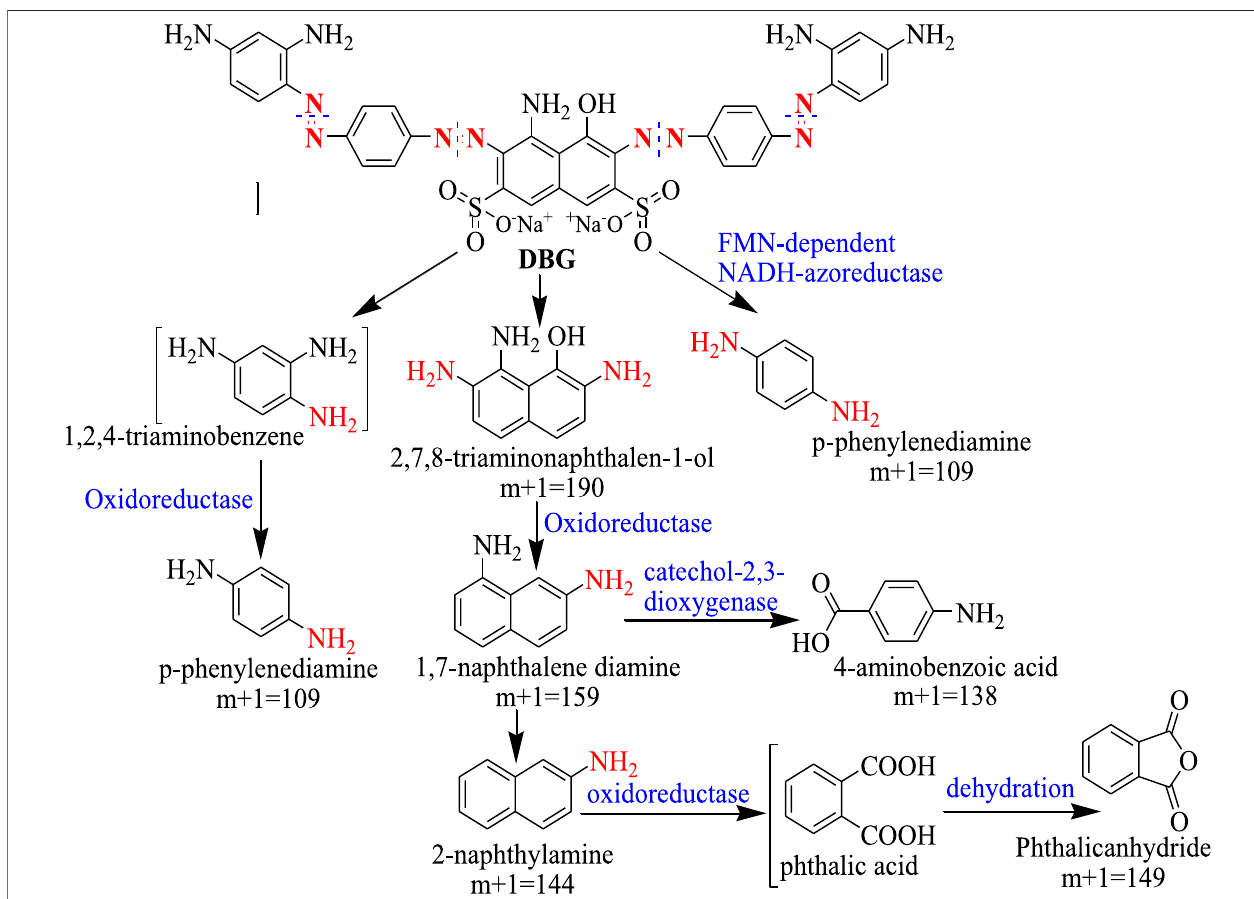
FIGURE 2 | Enzymatic mechanism for the degradation of Direct Black G dye by Anoxybacillus sp . PDR2. Adopted with Re-drawn from (Chen et al., 2021).